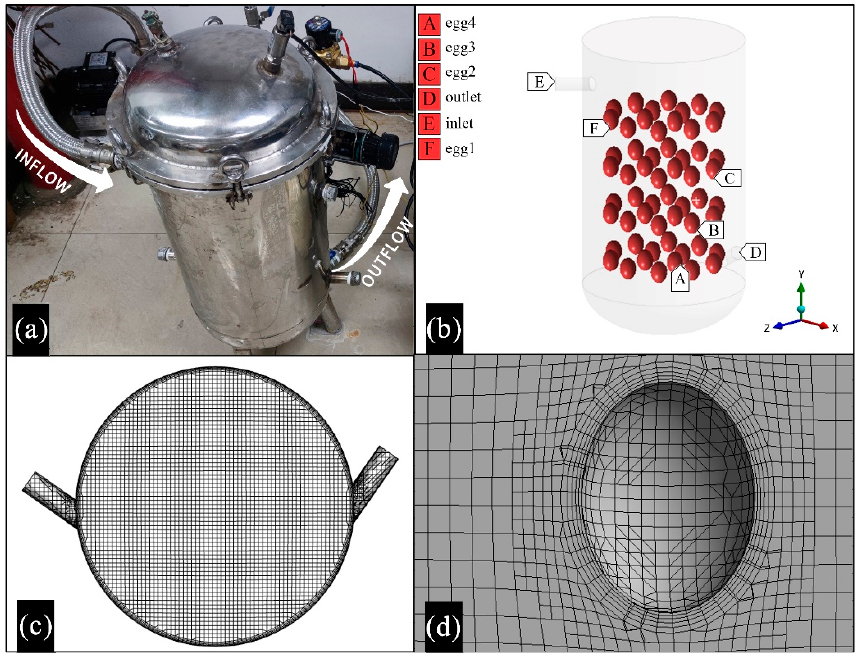
Figure 3. Models and computational meshes: ( a ) material object, ( b ) 3D model, ( c , d ) boundary conditions and computational meshes.